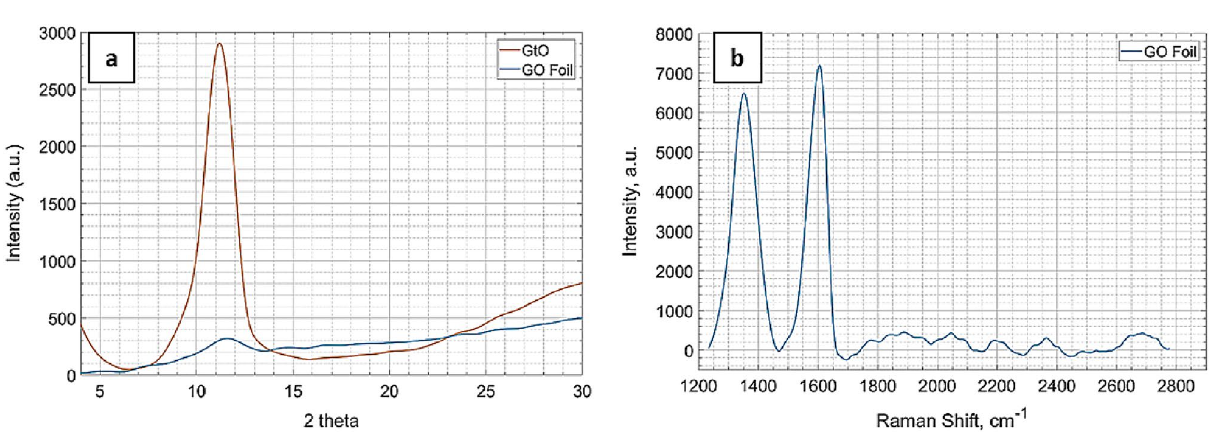
Figure 7. ( a ) Low-magnification SEM image of GO foil. ( b ) High magnification (×10,000) SEM image of GO foil. ( c ) Cross section SEM image of GO foil with onset at higher magnification (top100k, bottom 270 k).